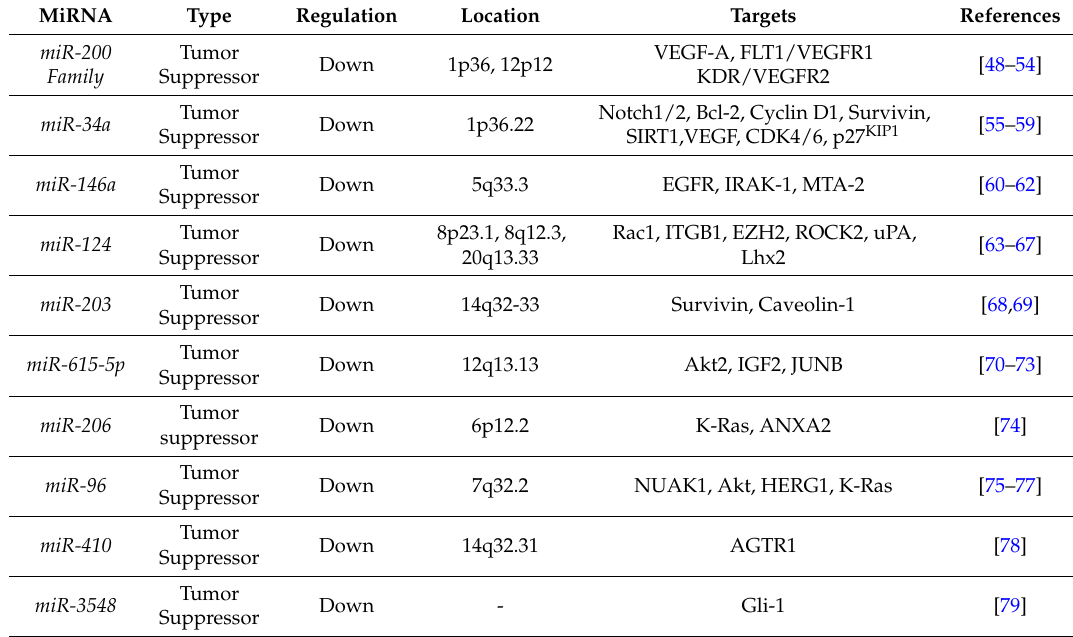
Table 2. Different Tumor suppressor miRNAs in pancreatic